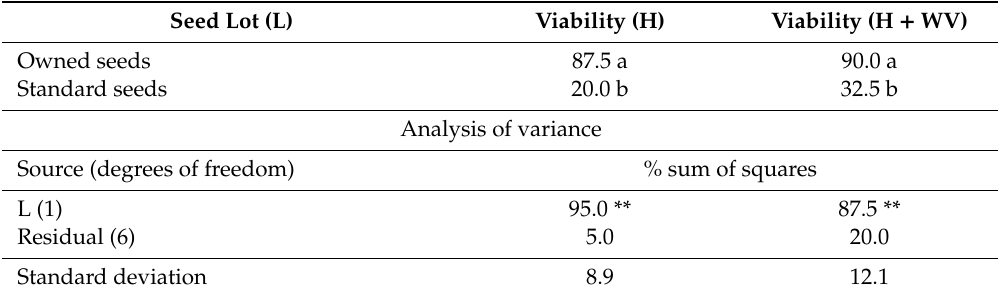
Table 6. E ff ects of the seed lot on the viability (%) of the seeds, considering only the healthy seeds (H) and considering both the healthy and viable but with weak tissues (H + WV). Mean